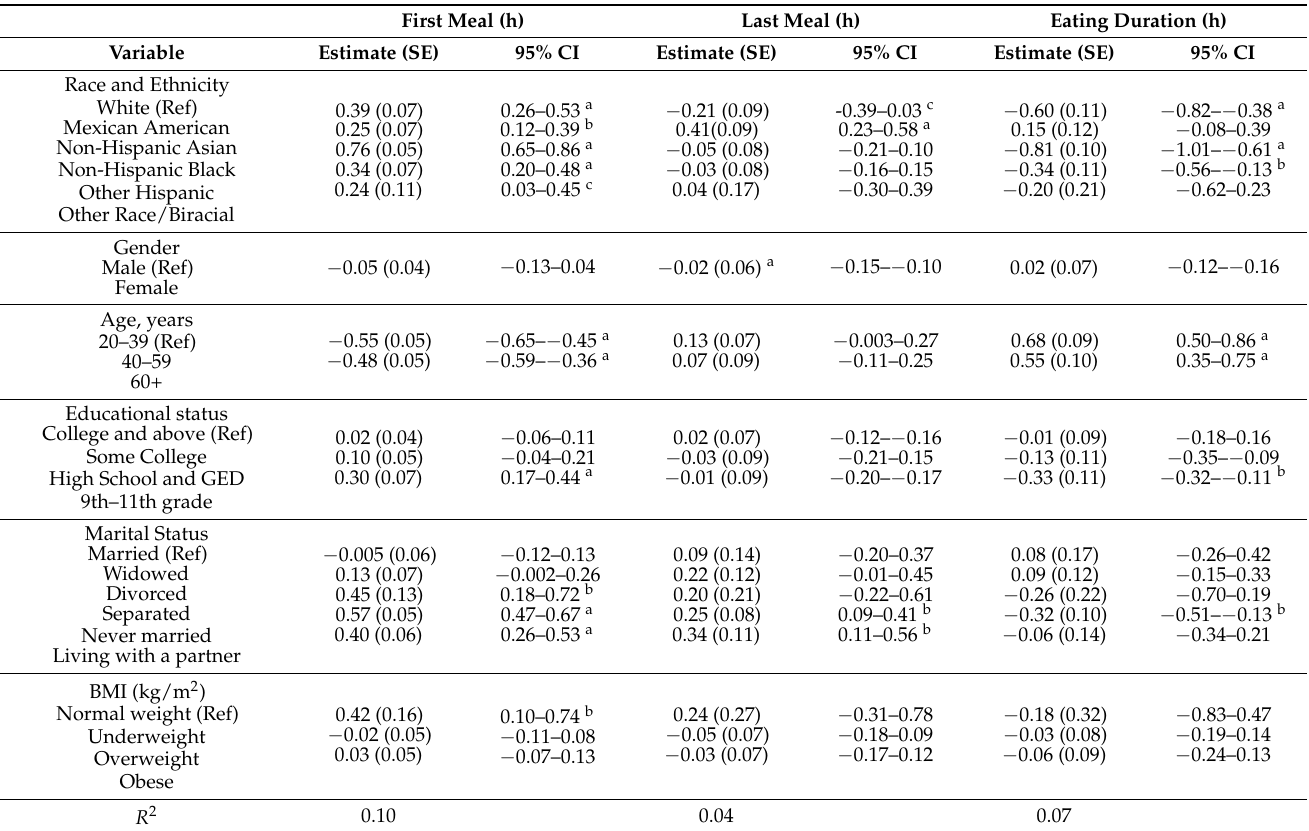
Table 2. Multiple Linear Regression Models for First Meal, Last Meal, and Eating Duration,